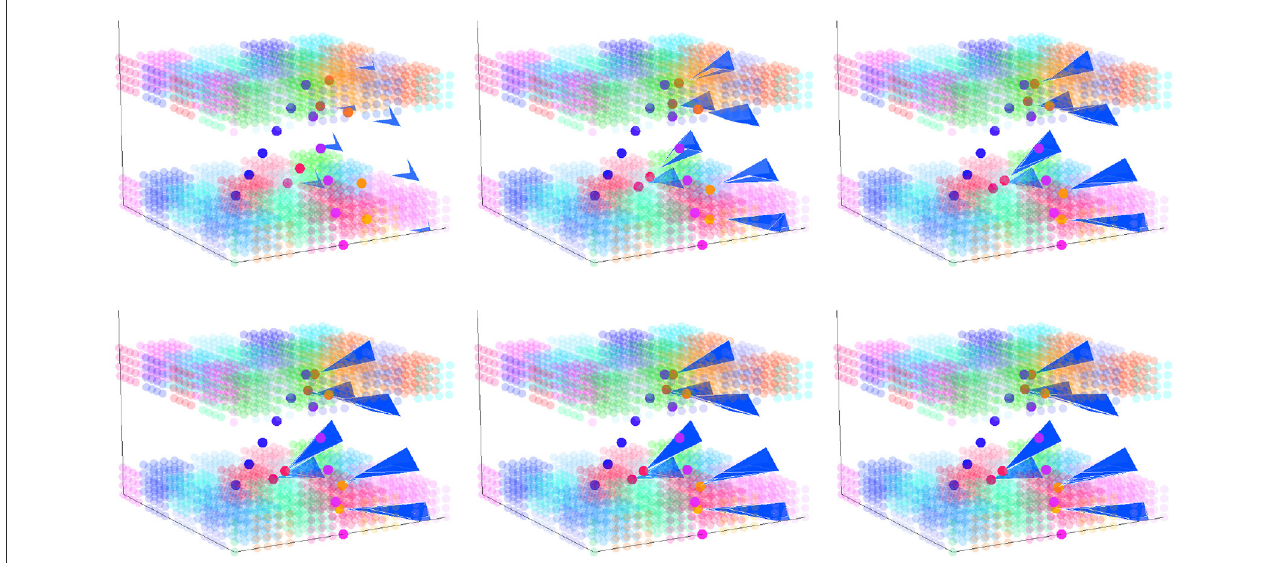
FIGURE7 Silhouette change over time with each iteration of practice in a 3D perceptual-motor space where the perceptual and motor spaces have identical layouts. The upper-left panel shows the starting silhouette (blue triangular shapes), the exemplar trajectory (blue to pink dots), and the output trajectory (red to orange dots). Reading from right-to-left and then top-to-bottom, the figure illustrates how the silhouette changes in shape as it incorporates the output trajectory from each prior production.